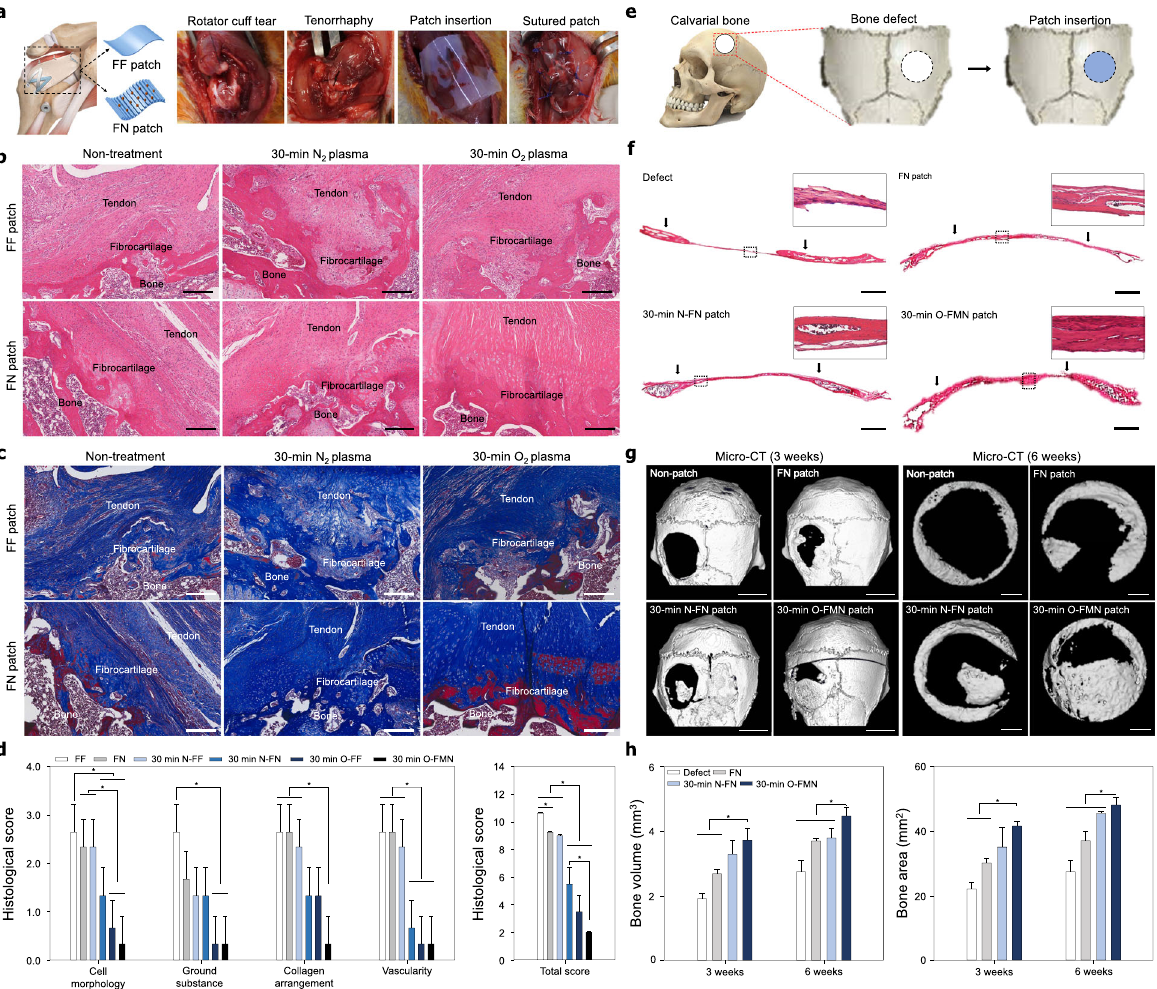
Fig. 4 Effect of the O-FMN patches on the tendon and bone tissue regeneration. a Surgical procedure for RC tendon repair. All patches were grafted onto the defected tendon tissue after tenorrhaphy of the torn RC tendon ( n = 3 for each group). b Representative histologic images of H&E staining and c Masson trichrome staining of the insertion site of FF, FN, 30-min N-FF, 30-min N-FN, 30-min O-FF, and 30-min O- FMN patches onto the supraspinatus tendon 4 weeks after repair. Scale bars = 200 µm. d Semiquantitative analysis of the histological evaluation scores on repaired tendon tissues of RC tear animal models. e Surgical procedure for rat calvarial bone repair ( n = 5 for each group). f Representative histologic images of H&E staining of the insertion site of FN, N-FN, and O-FMN patches onto rat calvarial bone 6 weeks after repair. Scale bars = 1 mm. g Representative micro-CT image after 3 and 6 weeks of repair. Scale bars = 5 mm (3 weeks). Scale bars = 1 mm (6 weeks). h Quantitative analysis of bone volume and area of the bone regeneration site after 3 and 6 weeks of repair. Error bars = mean ± standard deviation (* P <